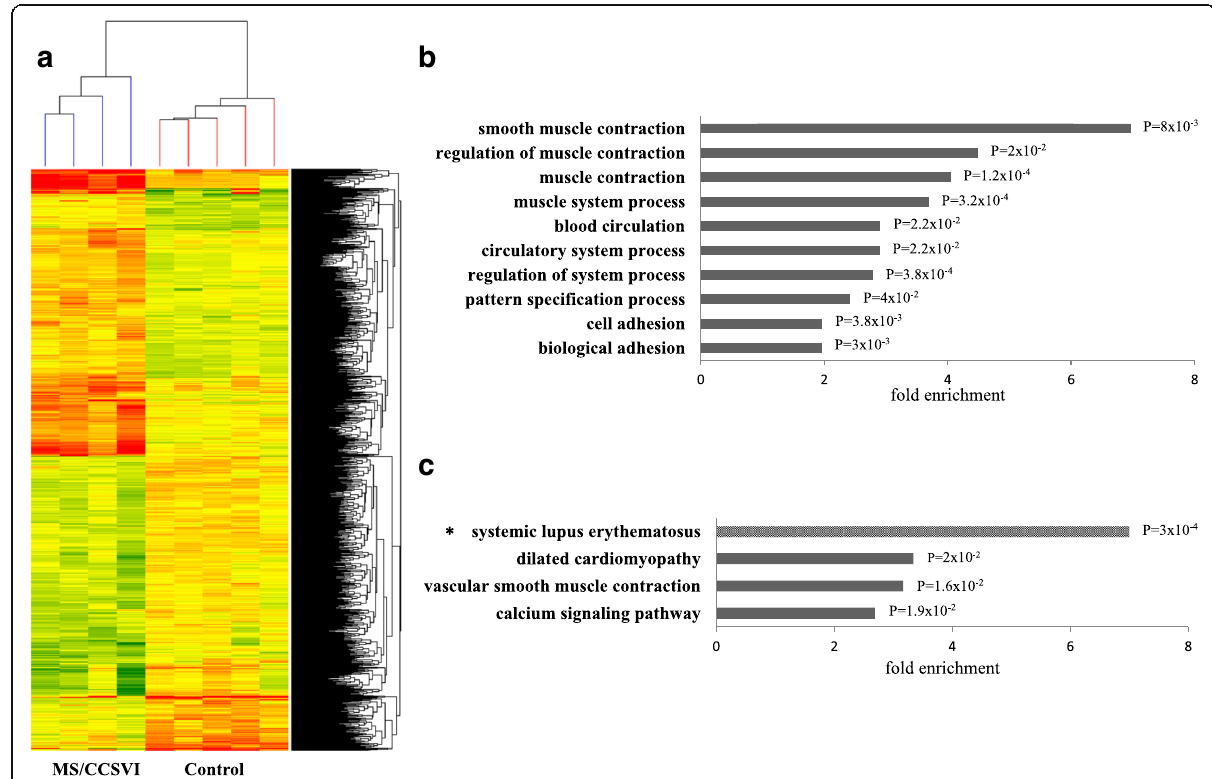
Fig. 1 Transcriptomic analysis in internal jugular vein walls. a Heat map representation of the 924 differentially expressed genes (1408 probes). Each column represents one RNA sample (MS/CCSVI and control jugular walls) and each row represents one gene (probe). Colors represent the expression level fold change: higher-red, lower- green and no difference-yellow. b Enriched biological processes and ( c ) pathways associated to the 924 genes differentially expressed between MS and control jugular walls. Significantly overrepresented terms (Benjamini test P <0.05) were selected from